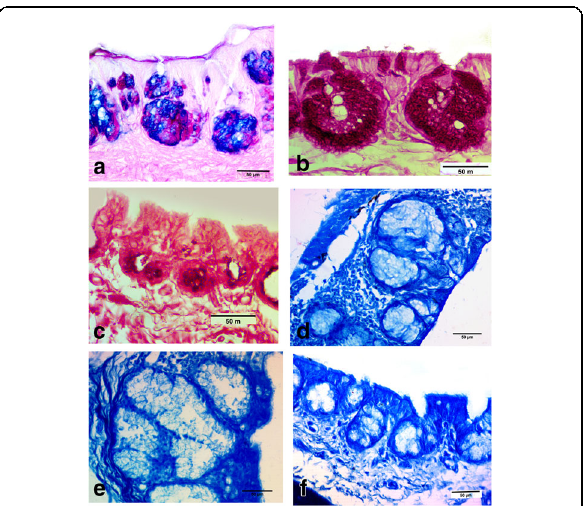
Fig. 14 Photomicrograph of a transverse section of choanal gland, a in kestrel with PAS-Alcian blue, b in hoopoe with PAS, c in common moorhen with PAS, d in kestrel with bromophenel blue, e in common moorhen with bromophenel blue, and f in hoopoe with bromophenel blue